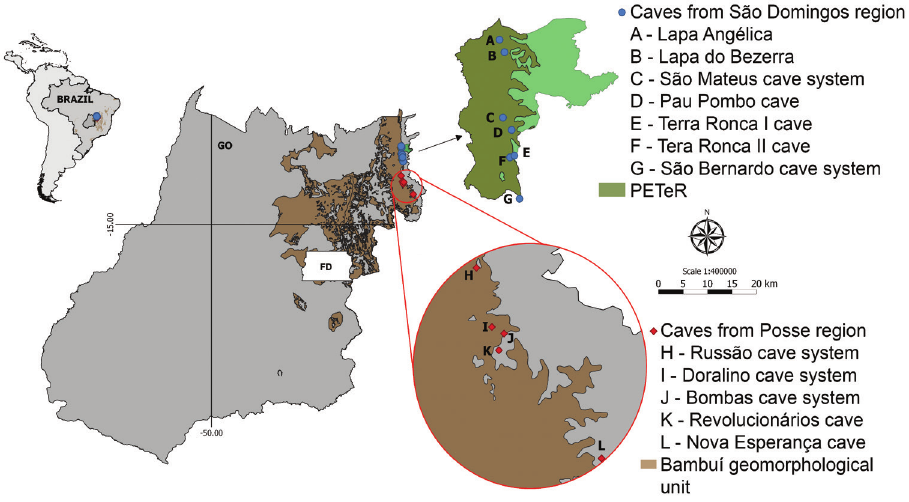
Figure 1. Map showing sampled caves from the São Domingos karst area (blue circles) within Terra Ronca State Park (PETeR, green area) and from the Posse karst area (red diamonds). FD, Federal District.